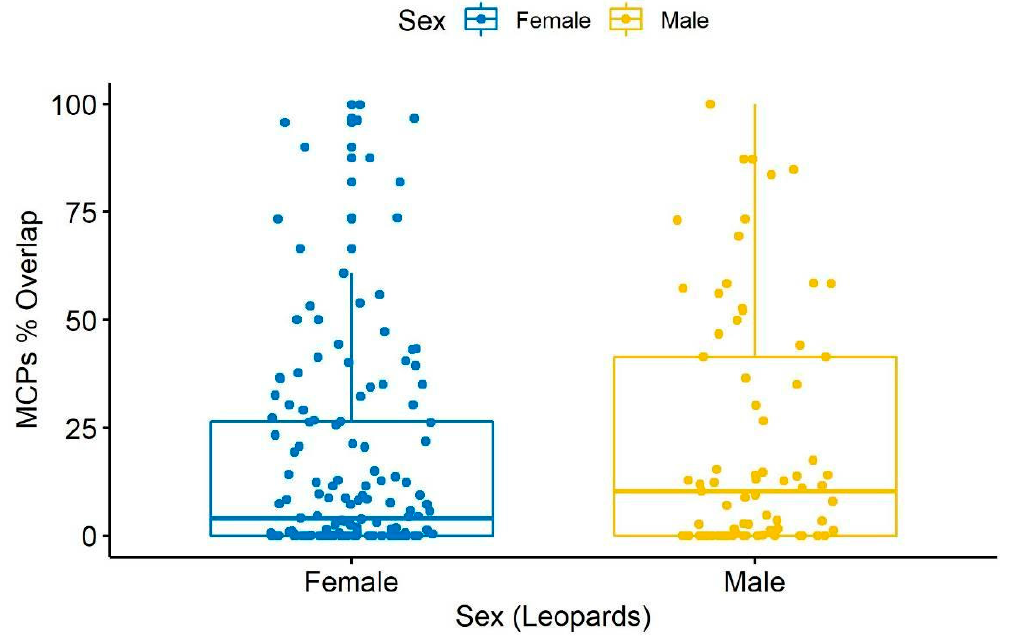
Figure 11. Percent Overlap of home-range (MCPs) area (in ha) of male and female leopards of Jhalana Reserve Forest, India.